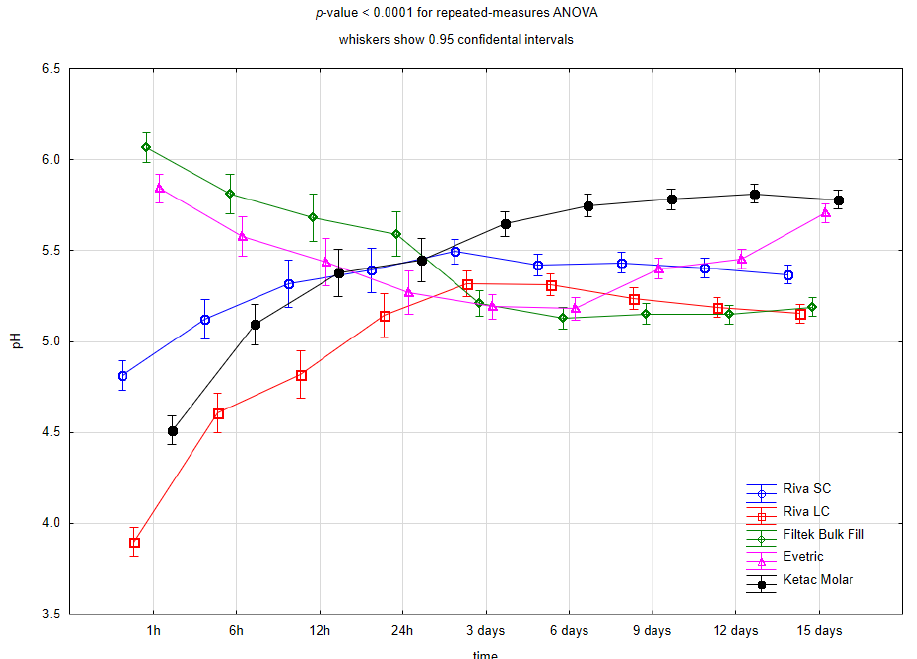
Figure 3. Repeated-measures analysis of variance for pH values in the individual time points depending on the dental restorative material for the two samples.